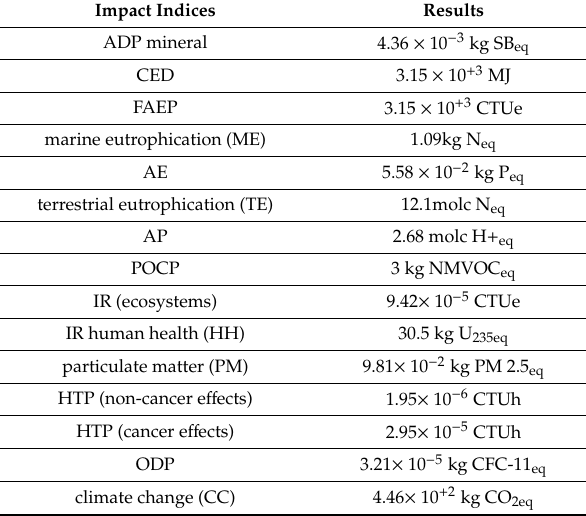
Table 6. Impact indices of the recycling process of 1000 kg of silicon PV